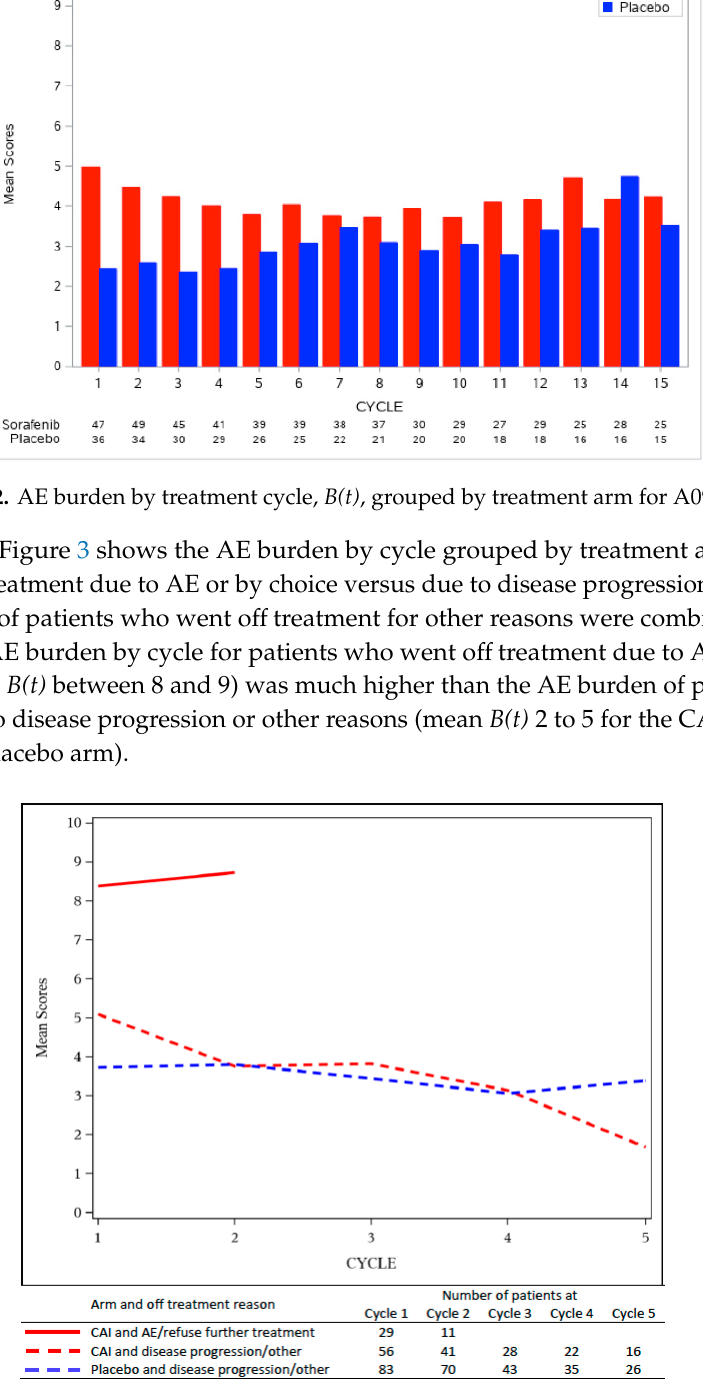
Figure 3. AE burden by treatment cycle, B(t) , grouped by treatment arm and by reason patient went off treatment for NCCTG 97-24-51. The AE burden of CAI patients who went off treatment due to adverse events (solid line) was higher than that of patients on either arm who went off for disease progression (dashed lines).